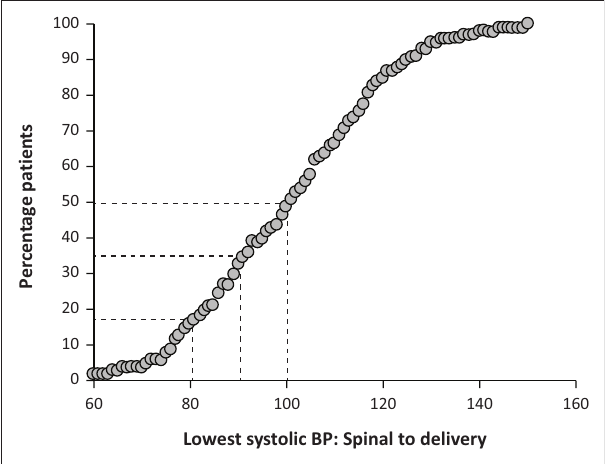
FIGURE 2: Incidence of obstetric spinal hypotension.